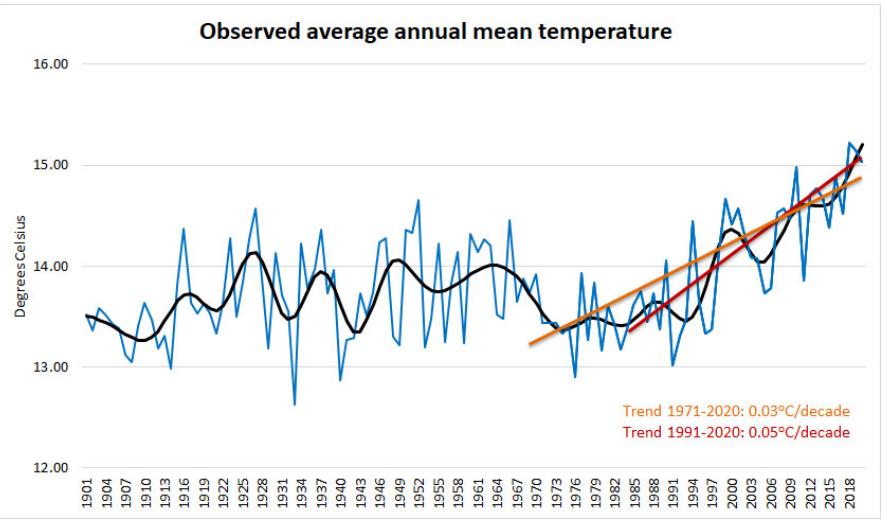
Figure 1. Mean annual temperature for the period 1901–2020 (blue line) and the 5-year MA (black line) and annual trends with significance over two recent periods: 1971–2020 and 1991–2020 (orange and red lines, respectively). Data source: World Bank Group, Climate Change Knowledge Portal.